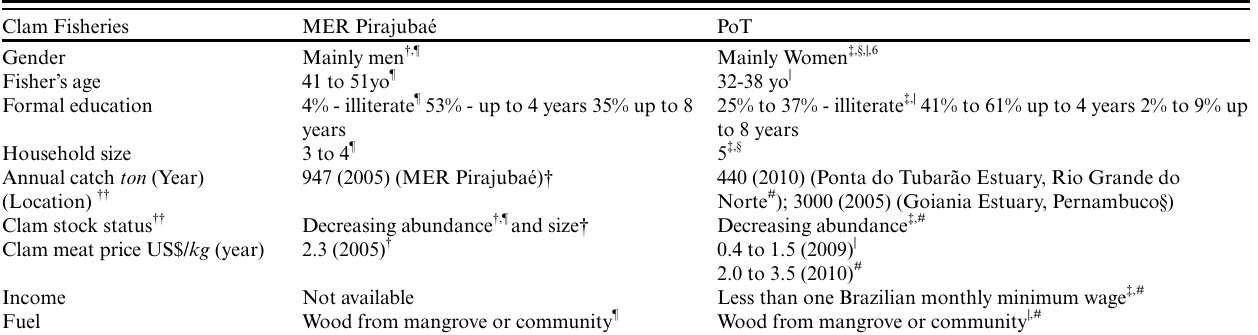
Table 2 . Clam fisher characteristics at Marine Extractive Reserve (MER) Pirajubaé and some communities involved in “People of the Tides”